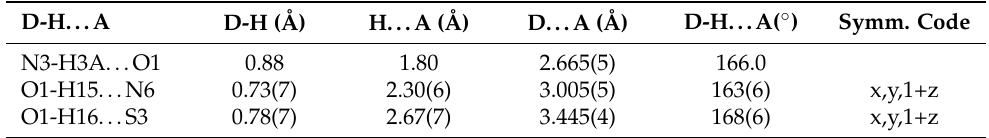
Table 5. The hydrogen bond parameters in 2 .